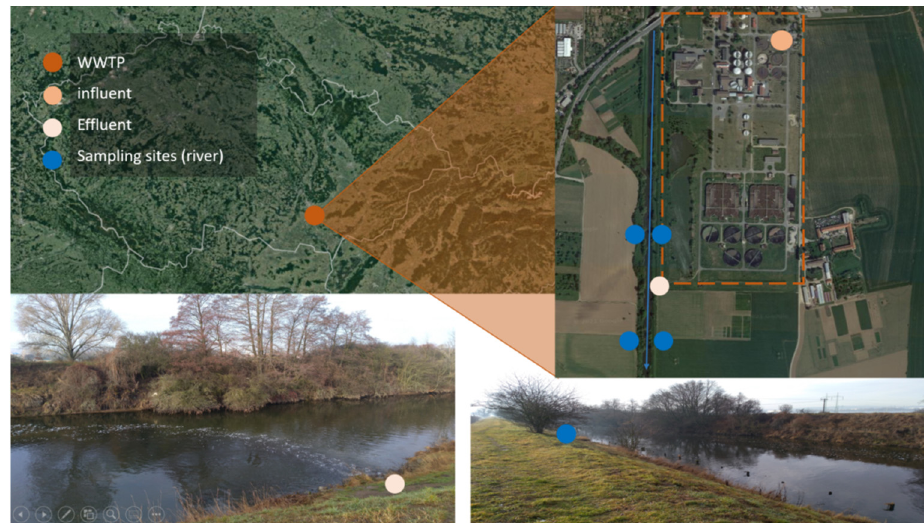
Figure 2 . The schema of sampling sites . Figure 2. The schema of sampling